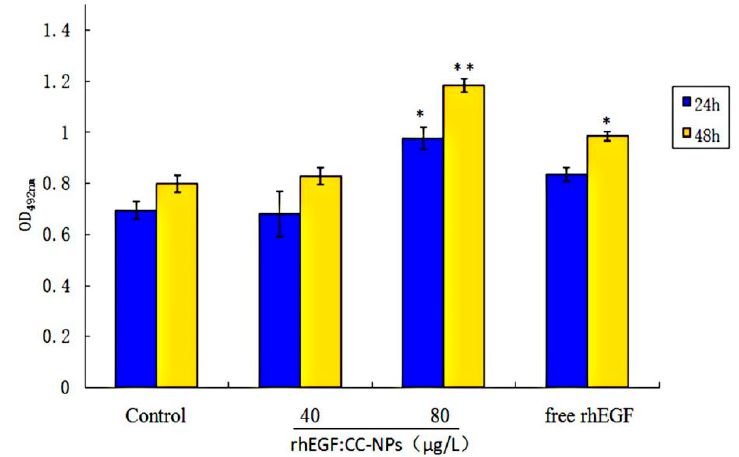
Figure 6. Proliferation of L929 cells when incubated with control, rhEGF:CC-NPs (40 μ g/L), rhEGF:CC-NPs (80 μ g/L), and free rhEGF (80 μ g/L) for 24 and 48 h. Note: * p < 0.05 vs. control, ** p < 0.01 vs. control.